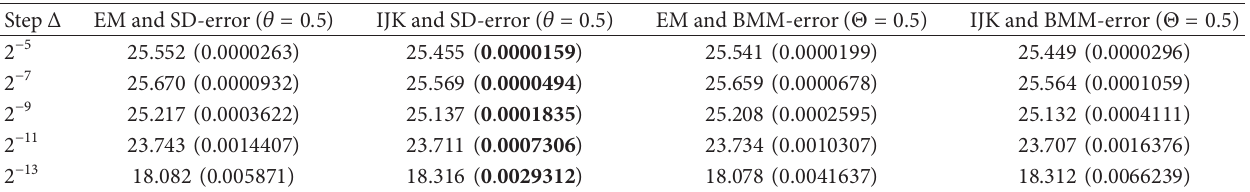
Table 8: 98% error, step size, and average computational time of numerical integration of process (𝑆 𝑡 ) using log-Euler or IJK method with SD or BMM scheme for (1) with (𝑥 0 ,𝑆 0 ,𝜇,𝑘 1 , 𝑘 2 ,𝑘 3 , 𝑞, 𝑇) = (1/16, 100, 0.05, 1/16, 1,0.4,3/4, 1) , correlation 𝜌 = −0.8 . Step Δ EM and SD-error (𝜃 =